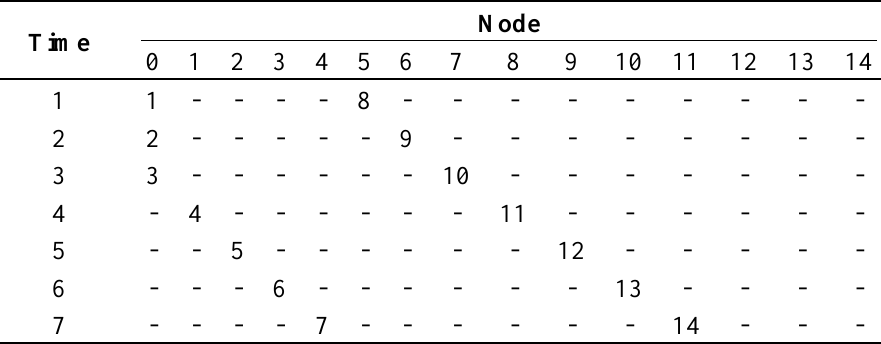
Table 7. Time schedule with REDUCE when n = 14, p =